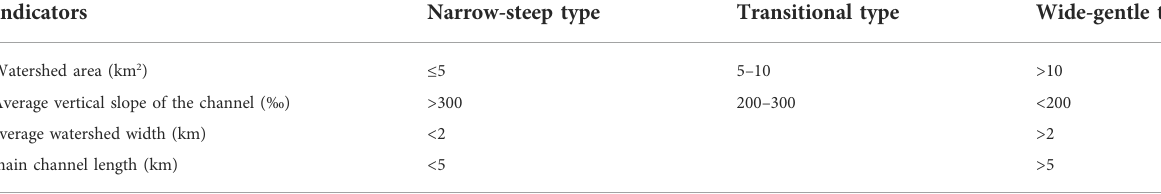
TABLE 2 Improved empirical discrimination model.